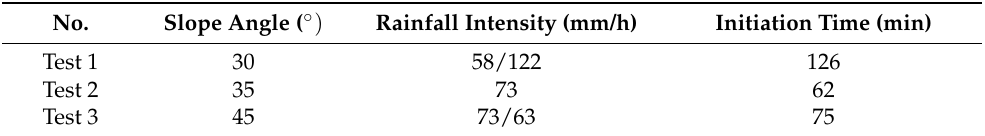
Table 8. Test conditions and landslide initiation